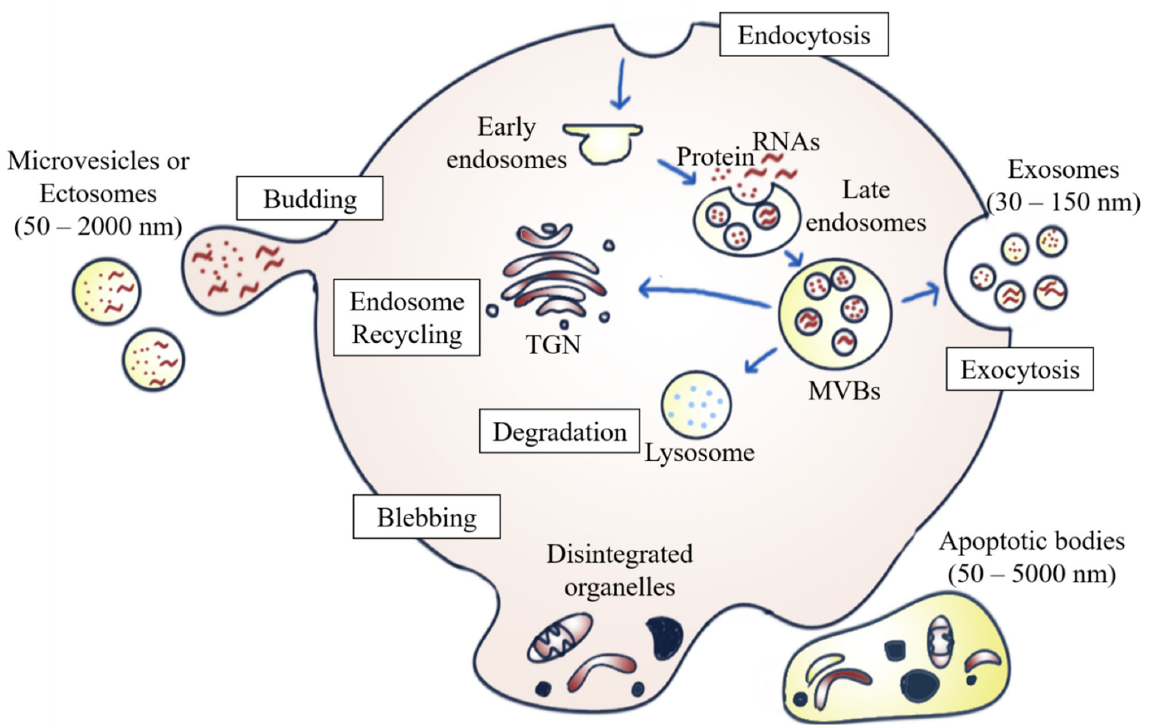
Figure 1. Biogenesis of different EV subpopulations. Exosomes originate from the fusion of the inward budding of MVBs formed via the endosomal pathway in the plasma membrane. ILVs are either secreted to the extracellular environment as exosomes upon fusion of multivesicular bodies (MVBs) with the plasma membrane, degraded by lysosomes, or recycled by trans ‐ Golgi network (TGN). Ectosomes are formed by outward budding from the plasma membrane, whereas apoptotic bodies are generated by membrane blebbing and fragmentation of apoptotic cells.